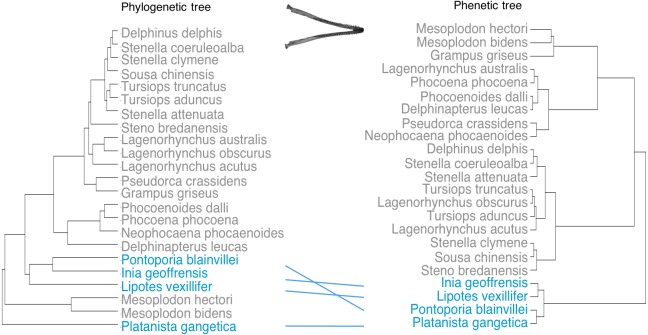
Tanglegram showing comparison in the position of the river dolphins on a phylogenetic tree and a phenetic tree based on mandibular morphology.Lines between trees link the same species and crossing lines indicate a lack of similarity in the two trees (e.g., where phenotype is more similar than implied by phylogeny, indicative of convergence). River dolphins are highlighted in blue.